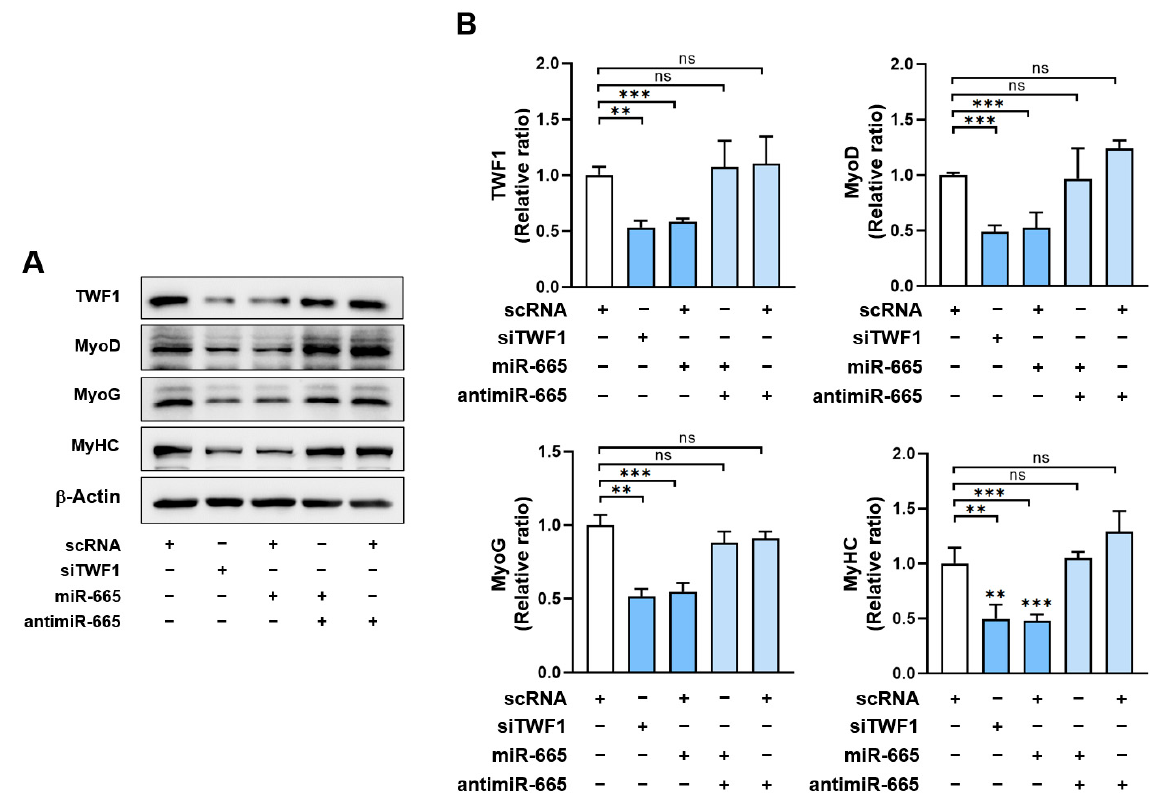
Figure 5. MiR-665-3p suppressed the expressions of myogenic regulator factors and TWF1. C2C12 cells were transfected with miR-665 mimic, antimiR-665, siTWF1, or scRNA (200 nM) and then differentiated for three days. ( A ) The expressions of TWF1 and myogenic factors were detected by immunoblotting. ( B ) Representative immunoblots of TWF1 and myogenic factors’ (MyHC, MyoD, and MyoG) expression as determined by densitometry and normalized versus β -actin. Results are expressed as the means ± SEMs of intensity ratios versus scRNA controls ( n = 3; ** p < 0.01; *** p < 0.001 vs. scRNA). ns: no